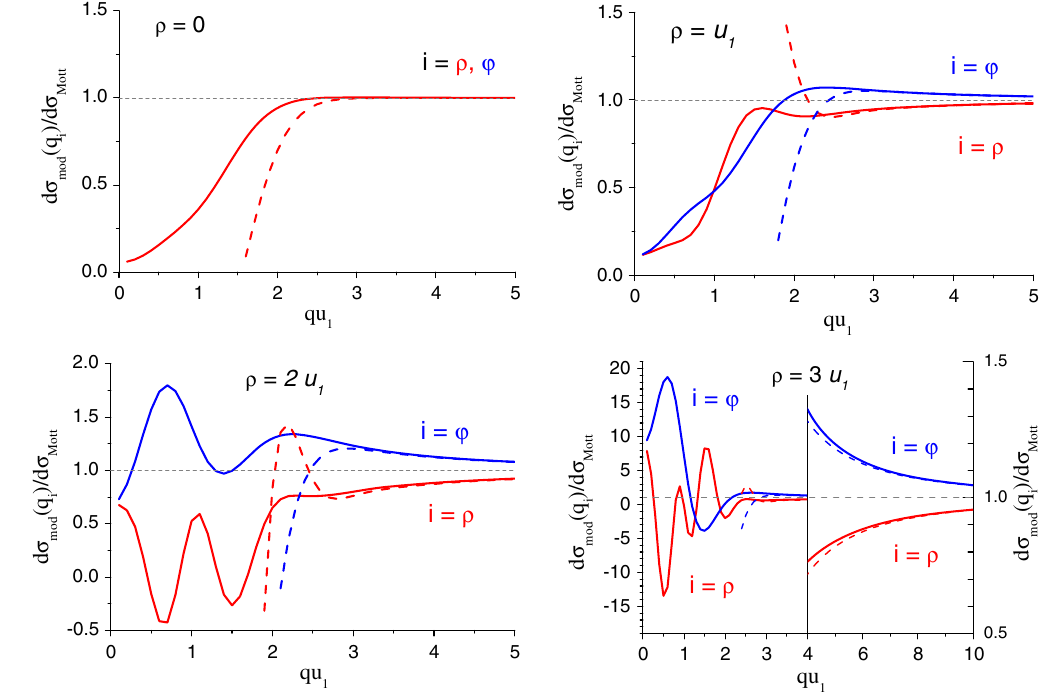
FIG. 4. Modified cross section dependence on the momentum transfer for radial ( i ¼ ρ ) and azimuthal ( i ¼ φ ) scattering directions, evaluated using the general (9) (solid lines) and asymptotic (10) (dashed lines) formulas for the radial coordinates ρ ¼ 0 (top left), ρ ¼ u ρ ¼ 2 u ρ ¼ 3 u 1 (top right), 1 (bottom left), and 1 (bottom right) of the scattering